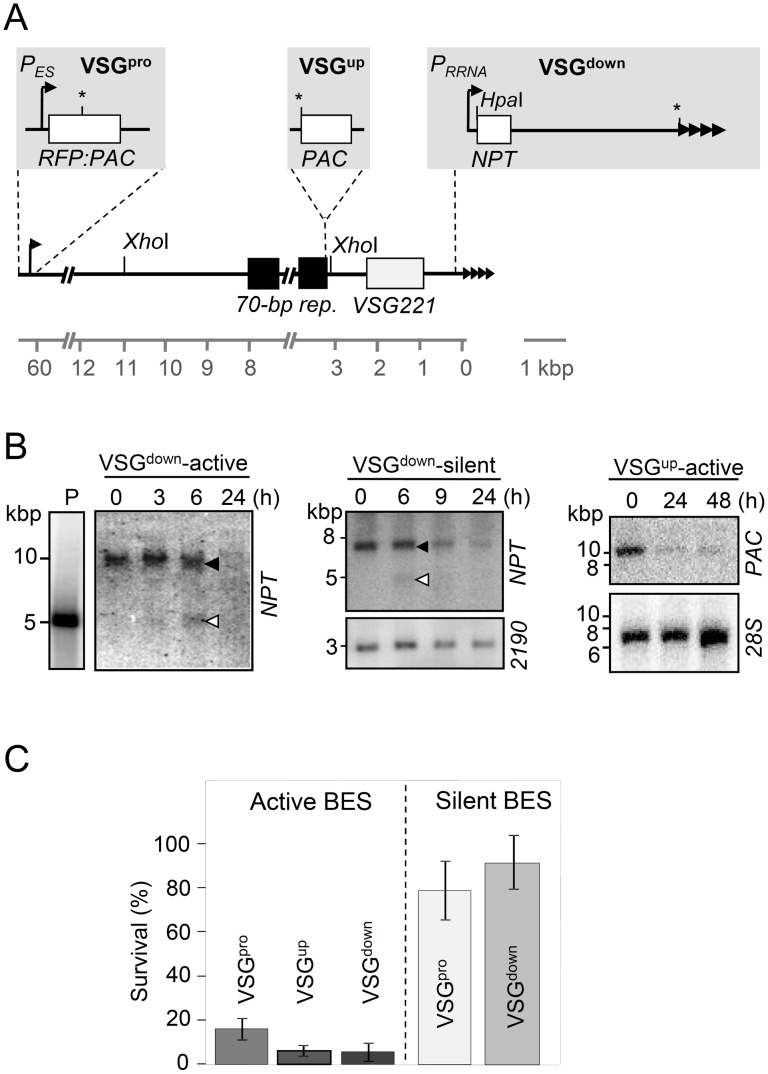
DNA double-strand breaks at an active VSG expression site are often lethal.(A) The schematic shows the VSG221 BES on chromosome 6a with the I-SceI sites (*) and reporters (NPT, Neomycin PhosphoTransferase; RFP-PAC, Red Fluorescent Protein-Puromycin N-ACetyltransferase; and PAC) incorporated using pESP-RSP, pES-70 or pTMF-Sce to give VSGpro, VSGup or VSGdown, strains respectively. Relevant restriction sites are shown. PES, BES promoter; PRRNA, ribosomal RNA promoter (allows for low-level NPT transcription when the BES is ‘silent’). (B) DSB-induction is rapid and efficient. I-SceI expression was induced with tetracycline (1 µg/ml), genomic DNA was extracted after different periods of time and digested with HpaI (VSGdown strains) or XhoI (VSGup strain); a plasmid control (P) was digested with HpaI/I-SceI. The probes are indicated and blots were rehybridized with either a ‘2190’ probe or a 28S probe to show loading. Terminal restriction fragments (closed arrowheads) and in vivo cleaved fragments (open arrowheads) are indicated. (C) Clonogenic assays. Cells in which I-SceI expression was induced were distributed in 96-well plates. Survivors were assessed after 7 days. Error bars, SD from three or more 96-well plates.